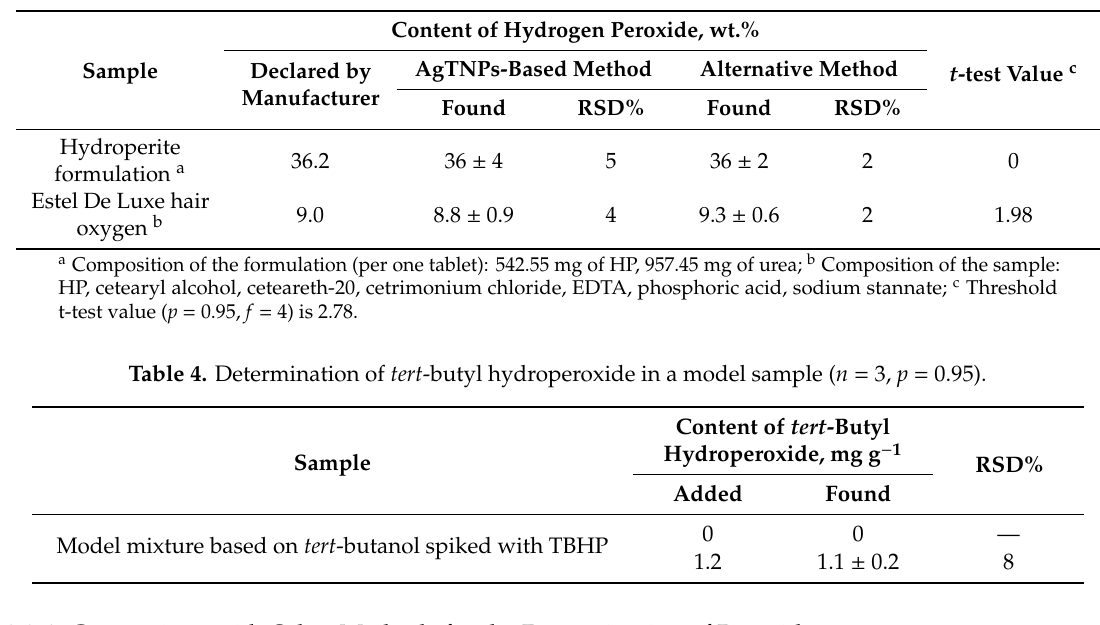
Table 3. Determination of hydrogen peroxide in samples ( n = 3, p = 0.95).